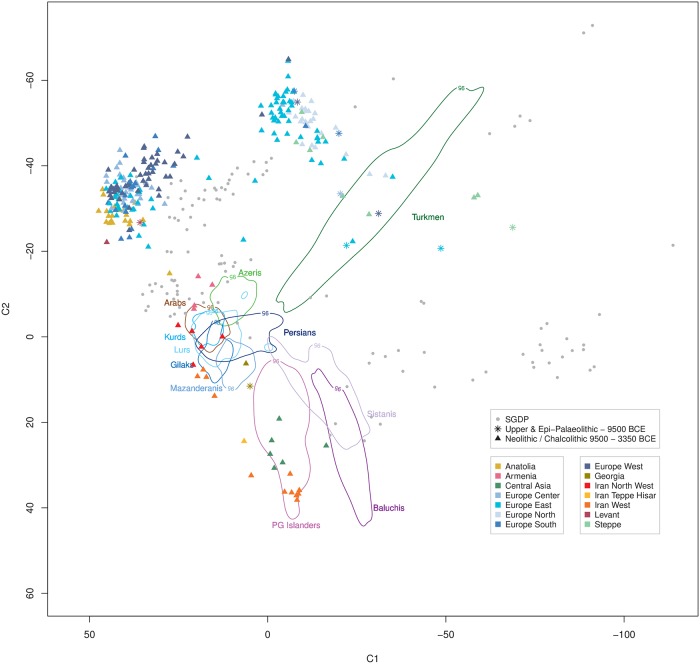
Ancient DNA samples from 45,000 (Upper Palaeolithic)–3350 BCE in the context of extant Iranian ethnic groups.Time-period specific ancient DNA samples (S3 Table) projected onto extant human variation (S18 Fig). The geographic origin of the ancient samples is coded by color.